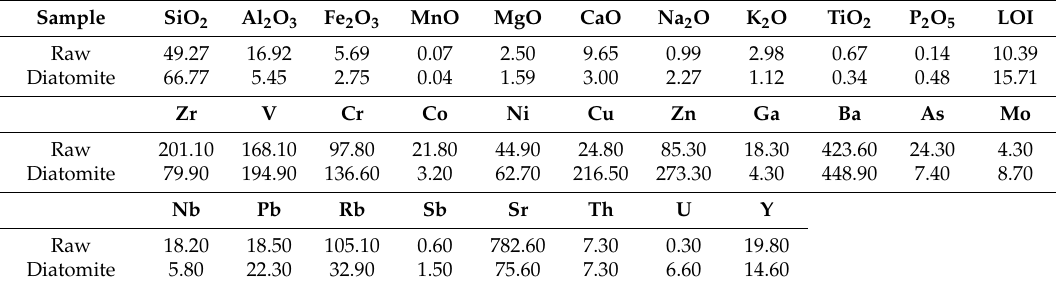
Table 1. Chemical analysis of major oxides (in wt%) and trace elements (in ppm) in the clayey earth raw material from Jun and the calcined diatomite sludge. LOI = loss on ignition.